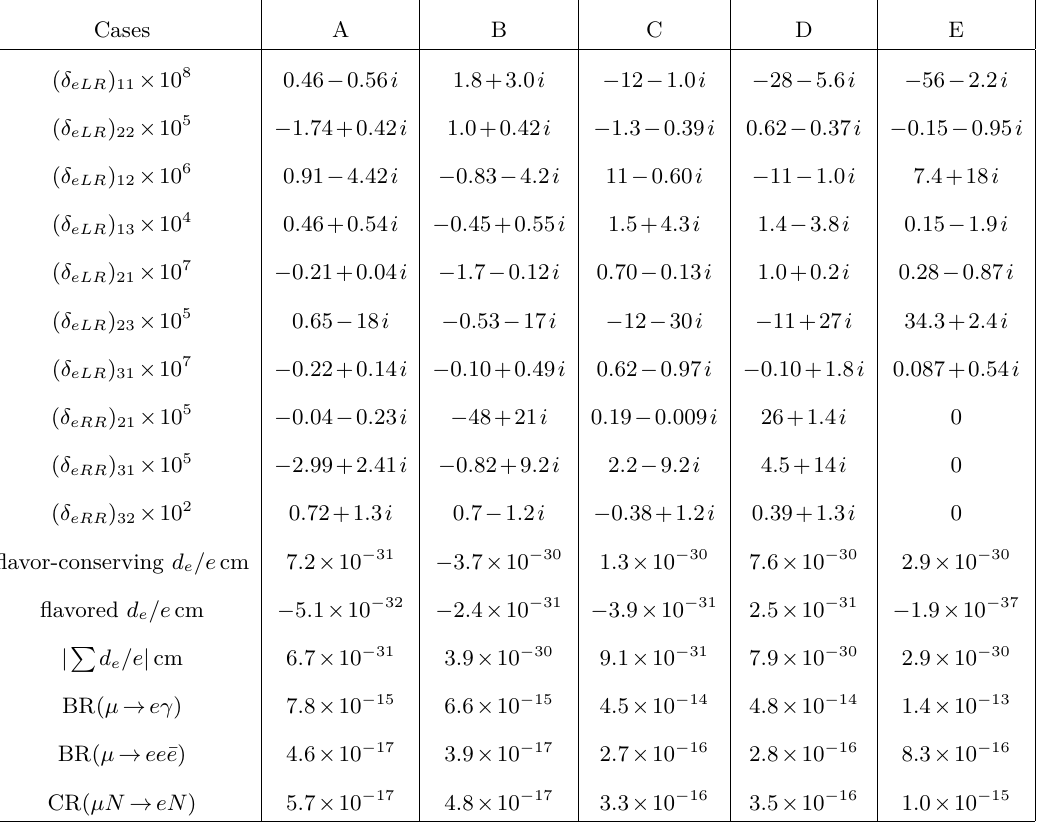
Table 4 . Mass insertion parameters and predicted d e /e (flavor-conserving EDM, flavored one and those sum), BR( µ → eγ ) , BR( µ → ee ¯ e ) and CR( µN → eN ) at M F τ = 5